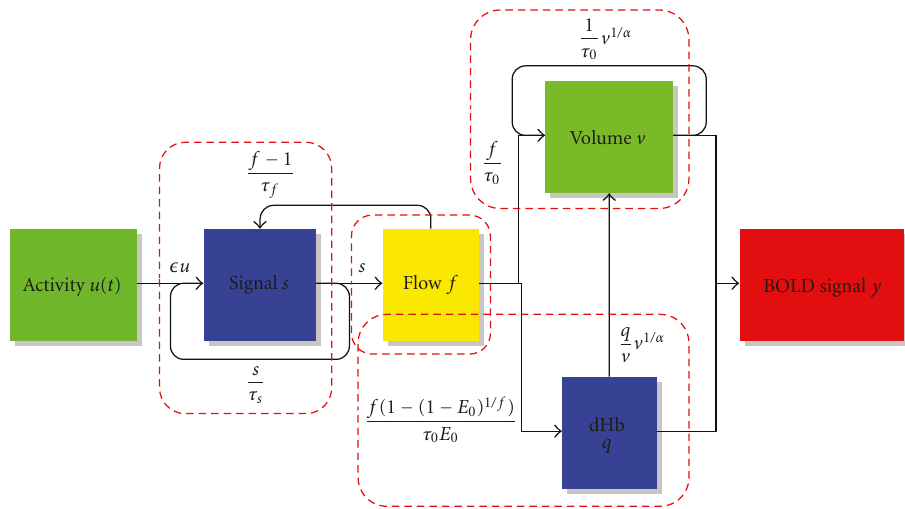
Figure 1: Schematic illustration of the hemodynamic model.